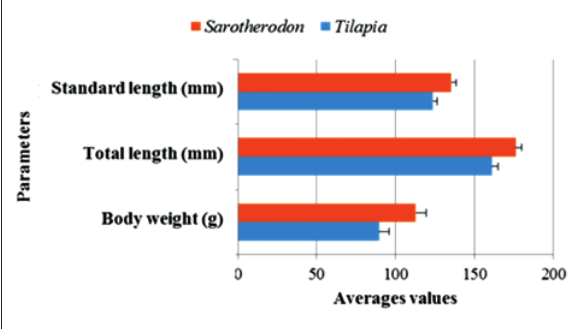
Figure-5: Morphometric parameters of Tilapia guineensis and Sarotherodon melanotheron in the lagoon of Porto-Novo